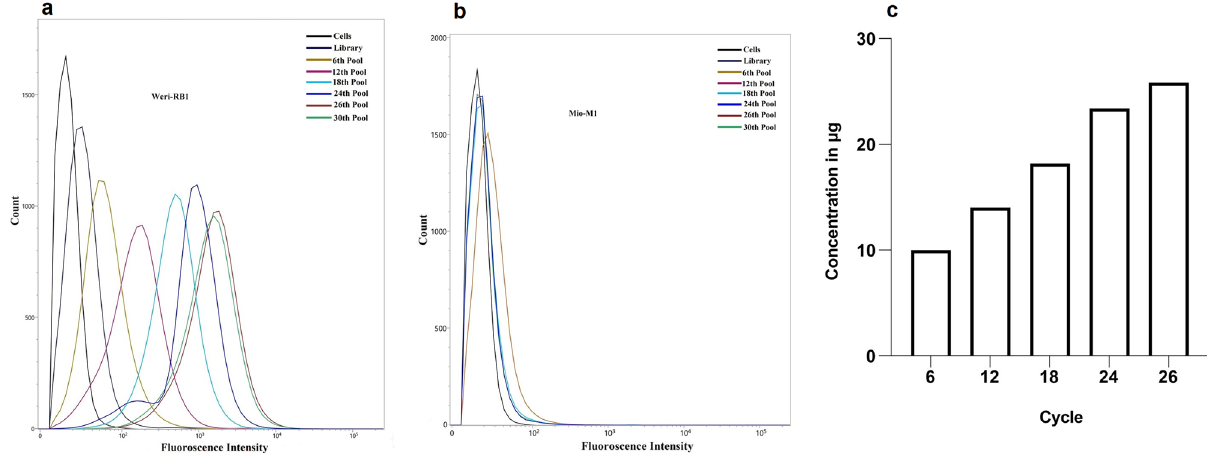
Figure 1. Monitoring the enrichment of the selected DNA libraries regarding the target cell line Weri-RB1 and control cell line Mio-M1 used for counter selection steps during the cell-SELEX process. ( a ) Fluorescence intensities of target cells incubated with FITC-labelled ssDNA pools from the initial library to the thirty- selection cycle. ( b ) Fluorescence intensities of negative control cells incubated with FITC-labelled ssDNA pools from the initial library to the thirty-selection cycle. ( c ) Represented is the ssDNA amount bound to the Weri-RB1 cells from the sixth to the twenty sixth selection